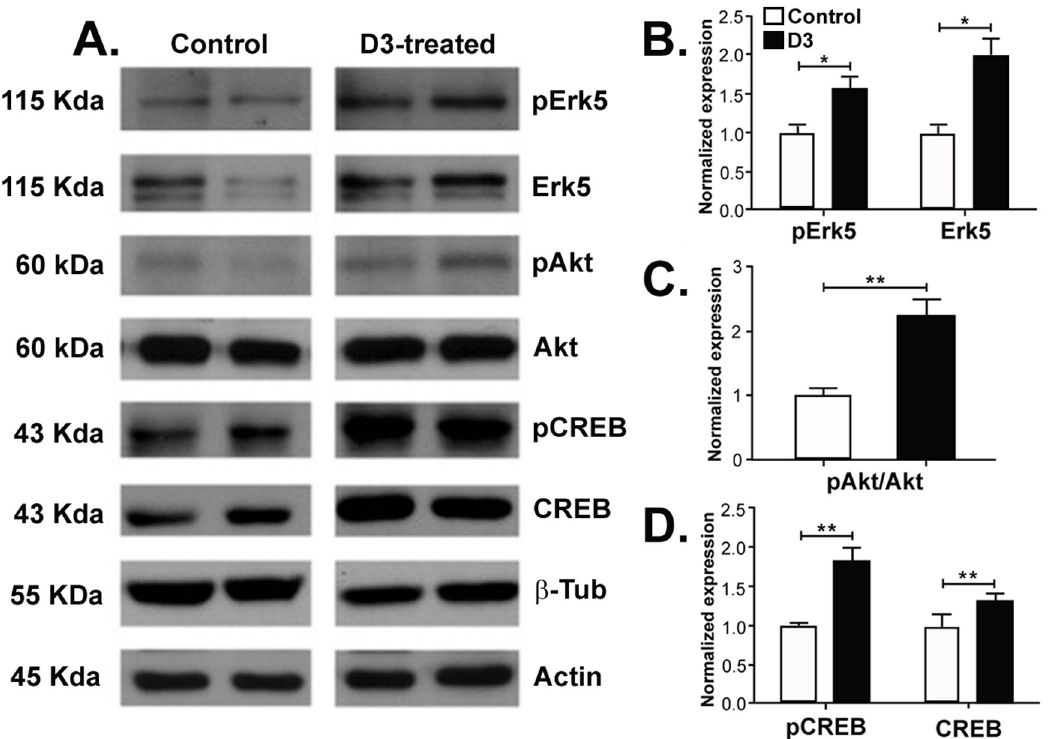
Fig 3. A 2-week treatment with D3 increases pErk5 Erk5, pAkt, pCREB and CREB in the hippocampus. (A) Representative Western Blots of proteins analyzed from hippocampus tissue. Increases in pAkt, total and pErk5, and total and pCREB were observed. Densitometry quantification of the bands shows a significant increase in (B) total Erk5 (p < 0.05), pErk5 (p < 0.05), (C) pAkt (p < 0.01), (D) total CREB (p < 0.01) and pCREB (p < 0.01) (controls: n = 3, D3: n = 3; two repeats of Western